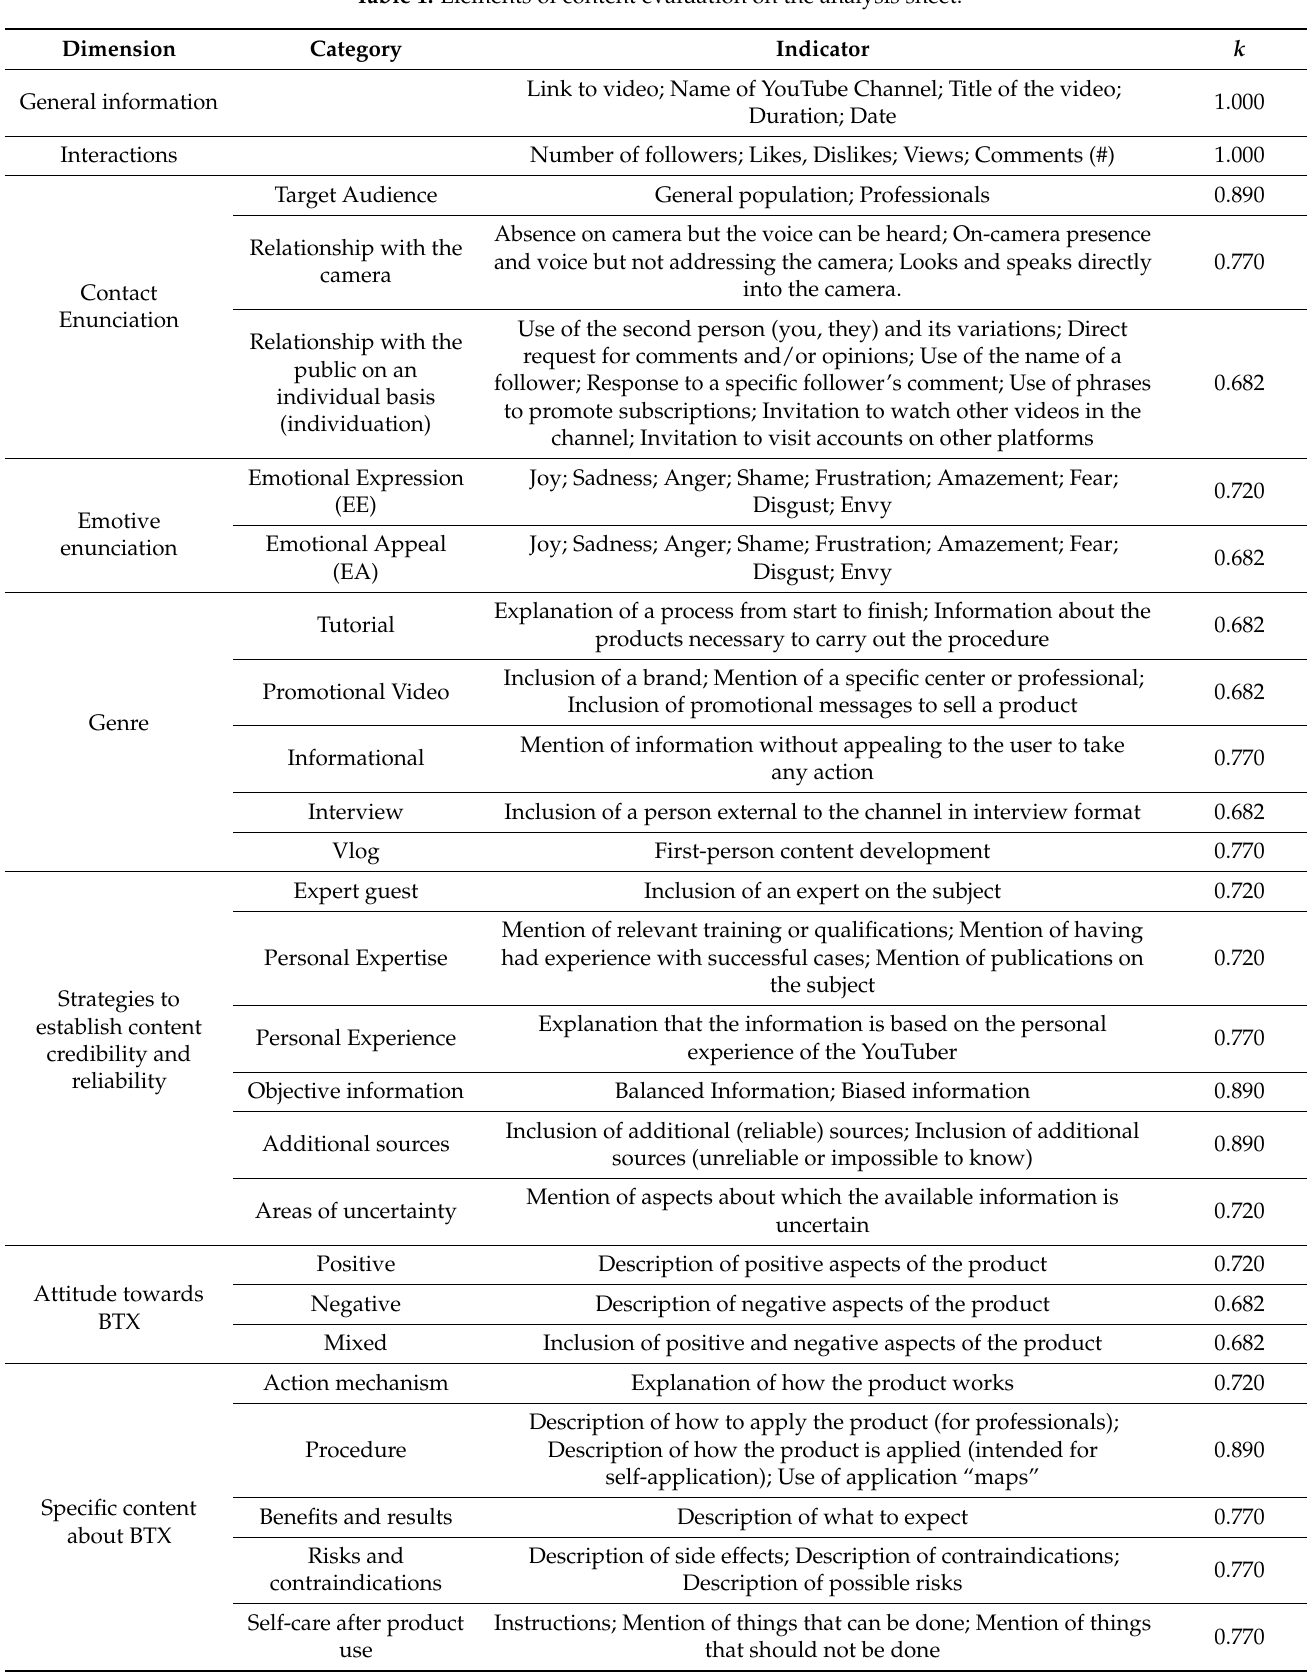
Table 1. Elements of content evaluation on the analysis